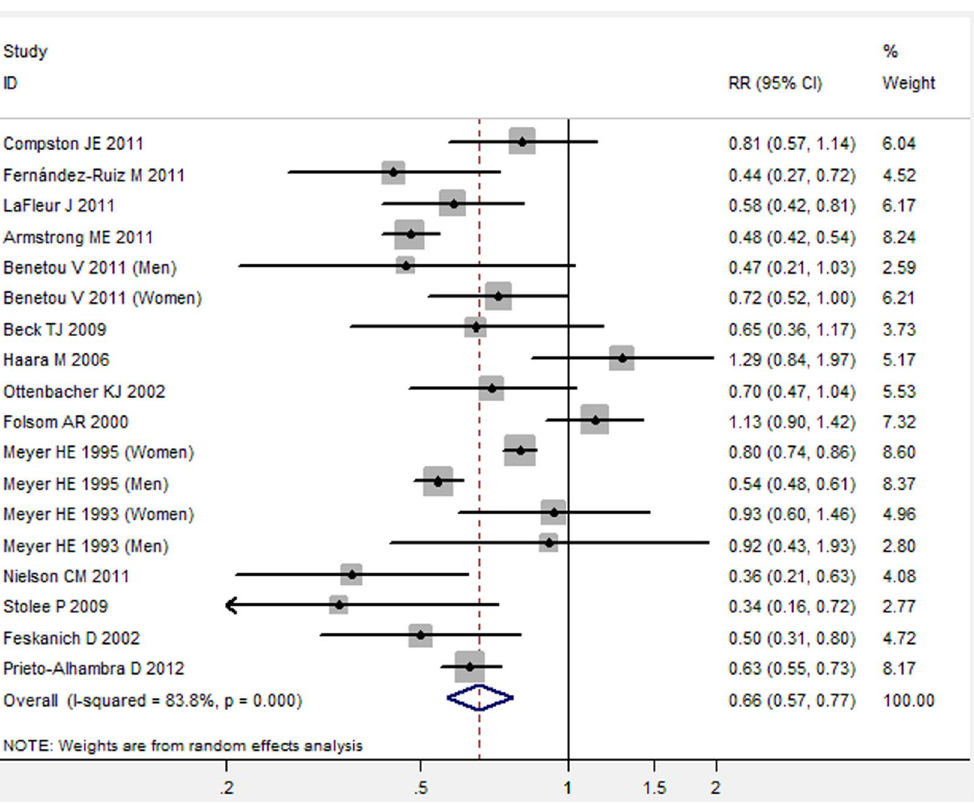
Figure 1. Forest plot showed an association between adult obesity and decreased risk of hip fracture (Meta-analysis of total included